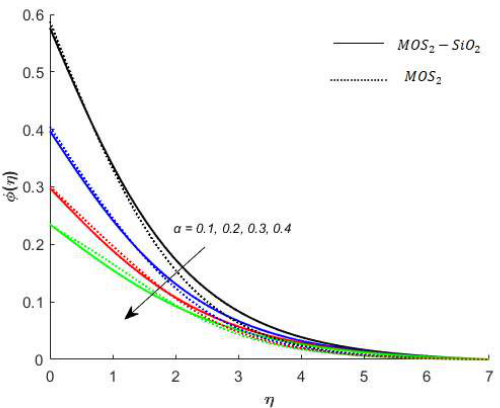
Figure 15. Variation in concentration for 𝐸𝑖 when 𝑀 = 0.2,𝑃𝑟 = 2.36,𝑆𝑟 = 0.1,𝑆𝑐 = 0.8,(𝐺𝑟) (cid:3030) = 0.1,𝐾 = 0.1,and 𝛽 ∗ = 0.1.